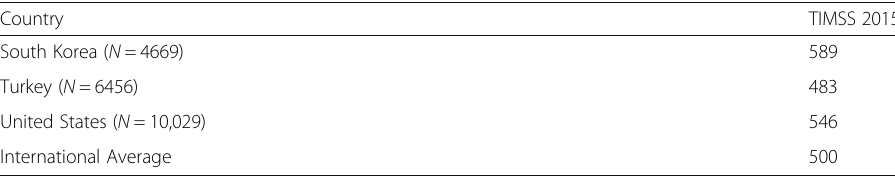
Table 2 TIMSS 2015 fourth grade science achievement scores for South Korea, Turkey, and the United